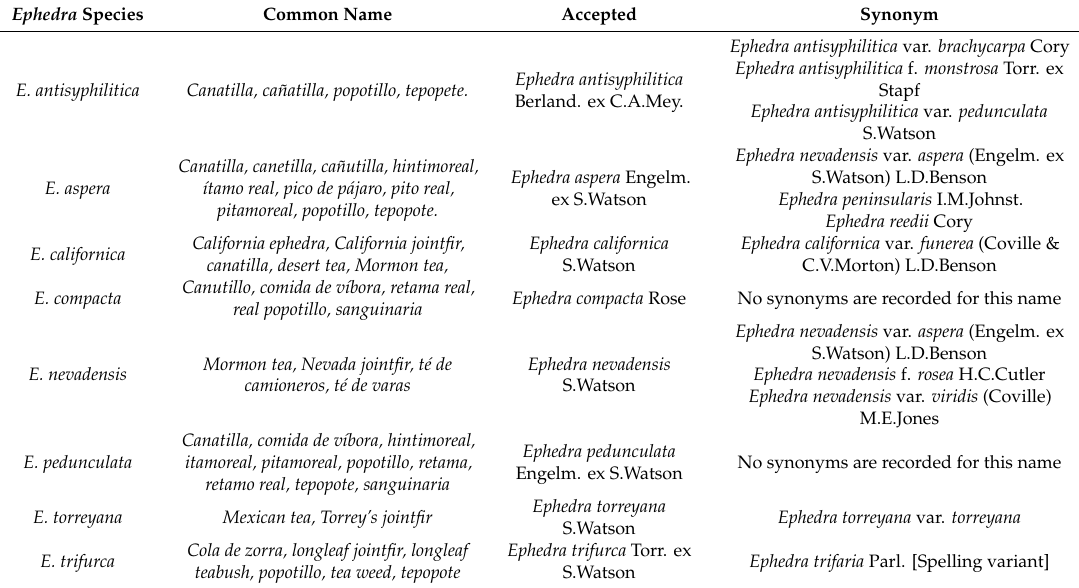
Table 1. Ephedra species in Mexico